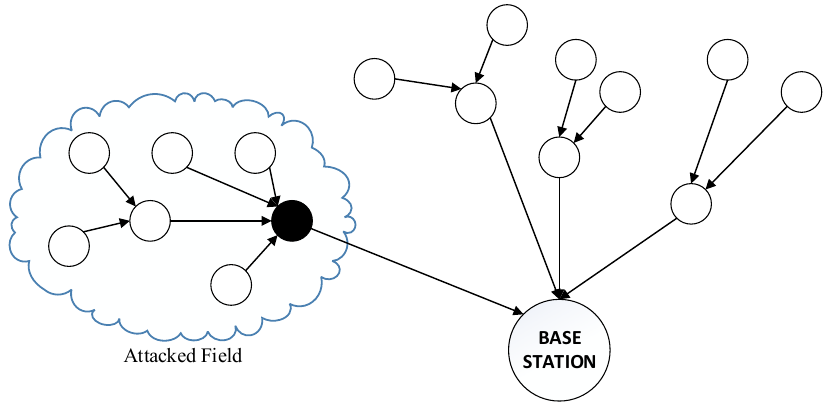
Figure 5. Demonstration of a Blackhole Attack. Wormhole Attack: In this attack, two malicious nodes establish a high-quality com- munication channel between each other. They then advertise this channel for routing, collecting data from neighboring sensor nodes. However, these nodes do not transmit the data either to the base station or transmit the data by changing it. The illustration of a Wormhole Attack is given in Figure 6.